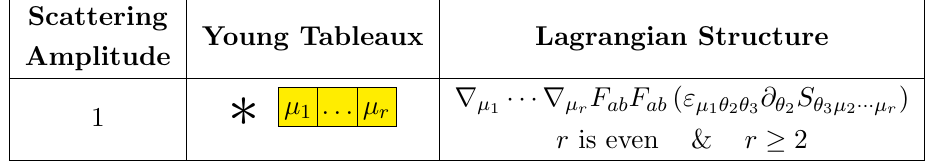
(cid:3) Table 5. Photons , D = 3. The symbol here signi(cid:12)es that one of the indices of the SO(2) symmetric tensor denoted in the second column of the table is Hodge dualized (i.e. r.h.s. of (3.13) is replaced by l.h.s. of (3.13))before we shade boxes and contract with the two photons.